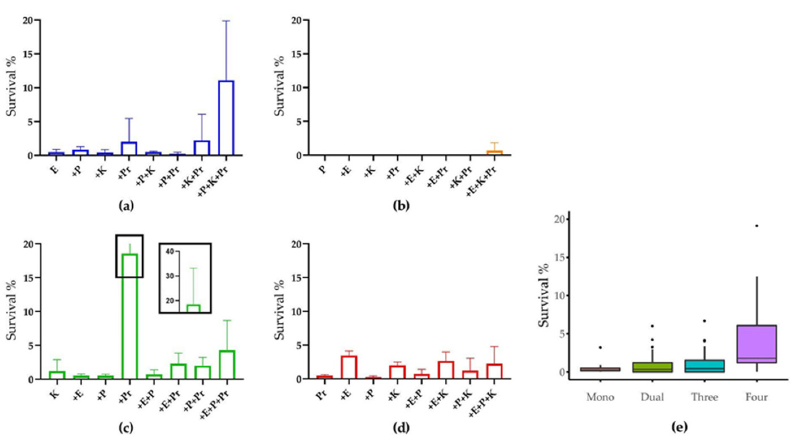
Figure 4. CIP susceptibility of strains in mono- and multispecies biofilms. Survival rate of ( a ) E. coli , ( b ) P. aeruginosa , ( c ) K. oxytoca and ( d ) P. mirabilis in monospecies biofilm or in combination with the other strains. ( e ) Overview of species survival rates in biofilms containing different numbers of species. The dots in penal ( e ) represent outliers within each data set. The experiment was performed in three biological replicates.